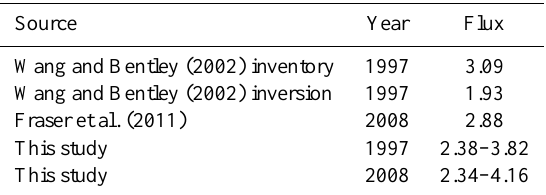
Table 3. Annual flux emissions (in Tgy − 1 ) from southeastern Aus- tralia for different years and from different